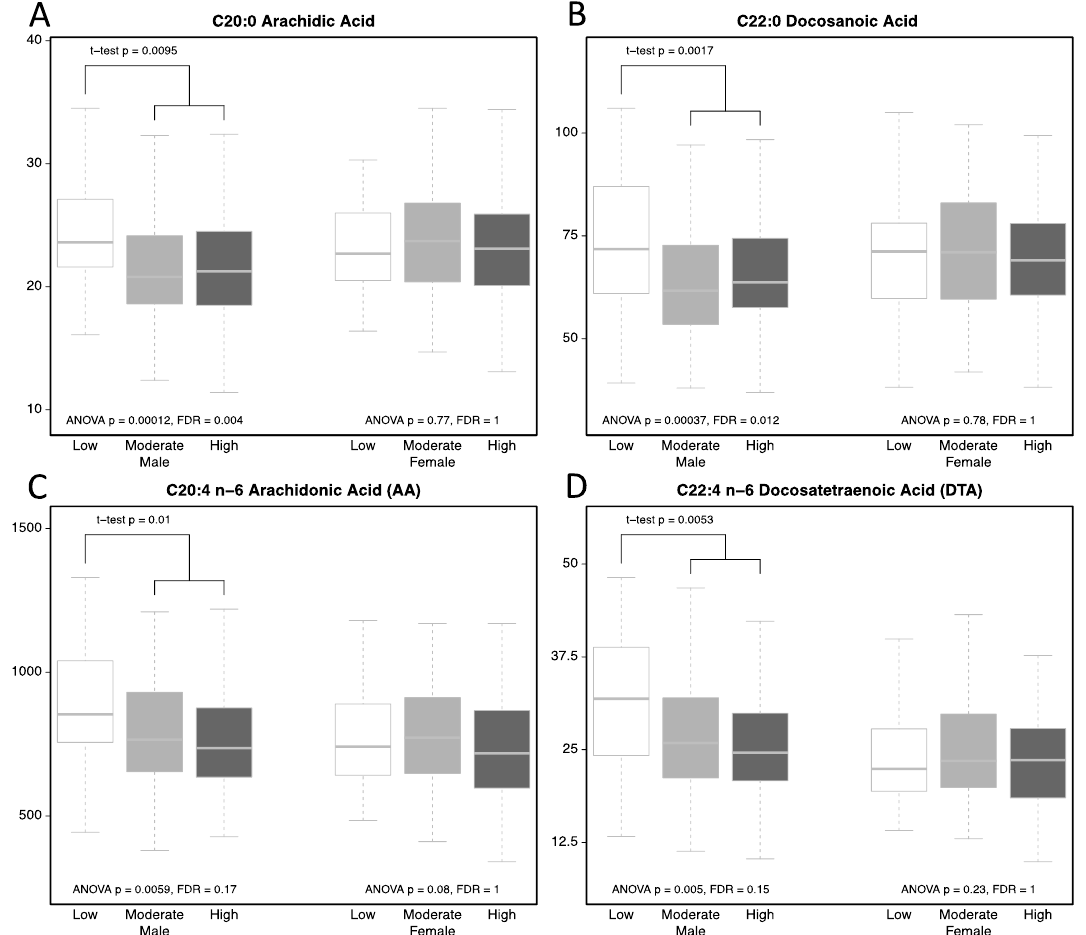
Figure 1. Boxplots of concentrations of 4 FAs ( A : Arachidic acid, B : Docosanoic acid, C : Arachidonic Acid, and D : Docosatetraenoic Acid) with significant association with CVFL stratified by sex. CVFLs were categorized into low (white), moderate (light gray), and high (dark gray). The levels of Men and Women were shown at the left and right side, respectively. In addition to ANOVA test among 3 CVFL groups, post-hoc pairwise t -test analysis was implemented in Men. Significant t -test p values comparing Low vs. Moderate + High CVFLs in men were shown in the figures. FAs: fatty acids; CVFL: cardiovascular fitness level; ANOVA: Analysis of Variance; FDR: false discovery rate. Table 4. ANOVA and pairwise t-test p values comparing Low vs. Moderate + High CVFLs in men. ANOVA p t -test p L vs. M vs. H L vs. M L vs. H M vs. H L vs. (M + H) Arachidic acid < 0.001 0.01 0.01